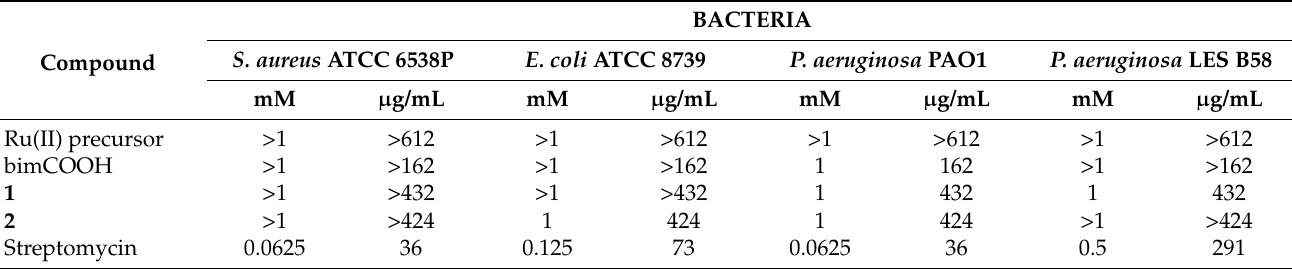
Table 6. Results of the minimum inhibitory concentration (MIC) for Ru compounds evaluated, expressed in mM and µ